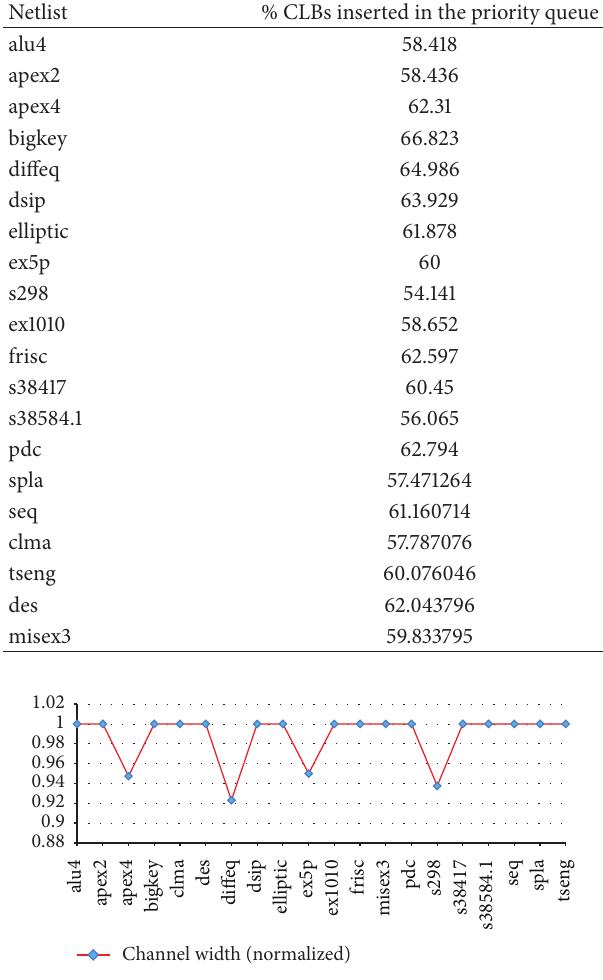
Figure 2: Comparative results of standard deviation in interconnect demand for diffusion based placement algorithm fixed approach normalizedtotherespectiveresultsfromVPRsplacementalgorithm for cluster size 𝑁 = 4